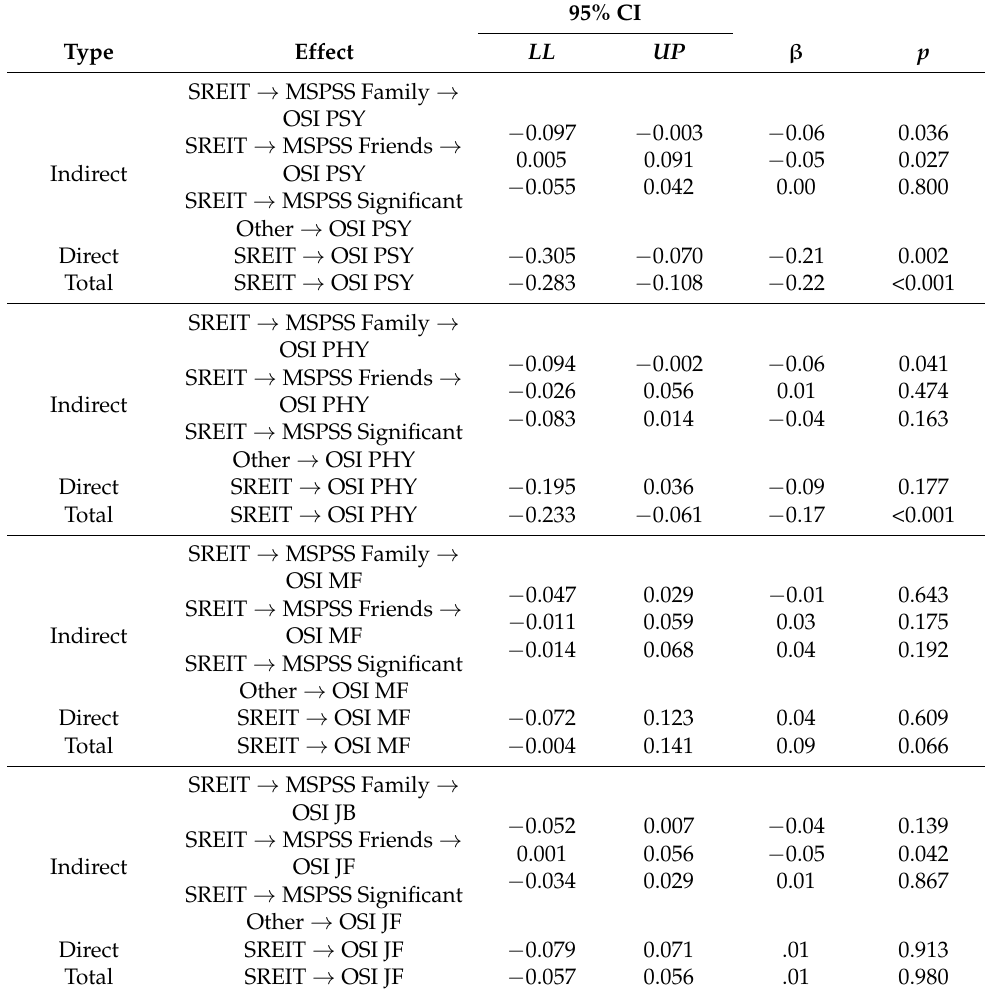
Table 4. Relationships between emotional intelligence (EI), social support, and occupational